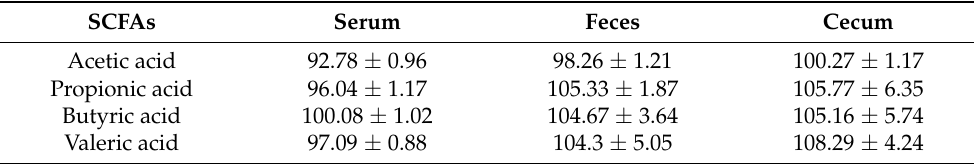
Table A1. Spike recovery results between water and serum, feces, and cecum ( n = 3, mean ± standard deviation).